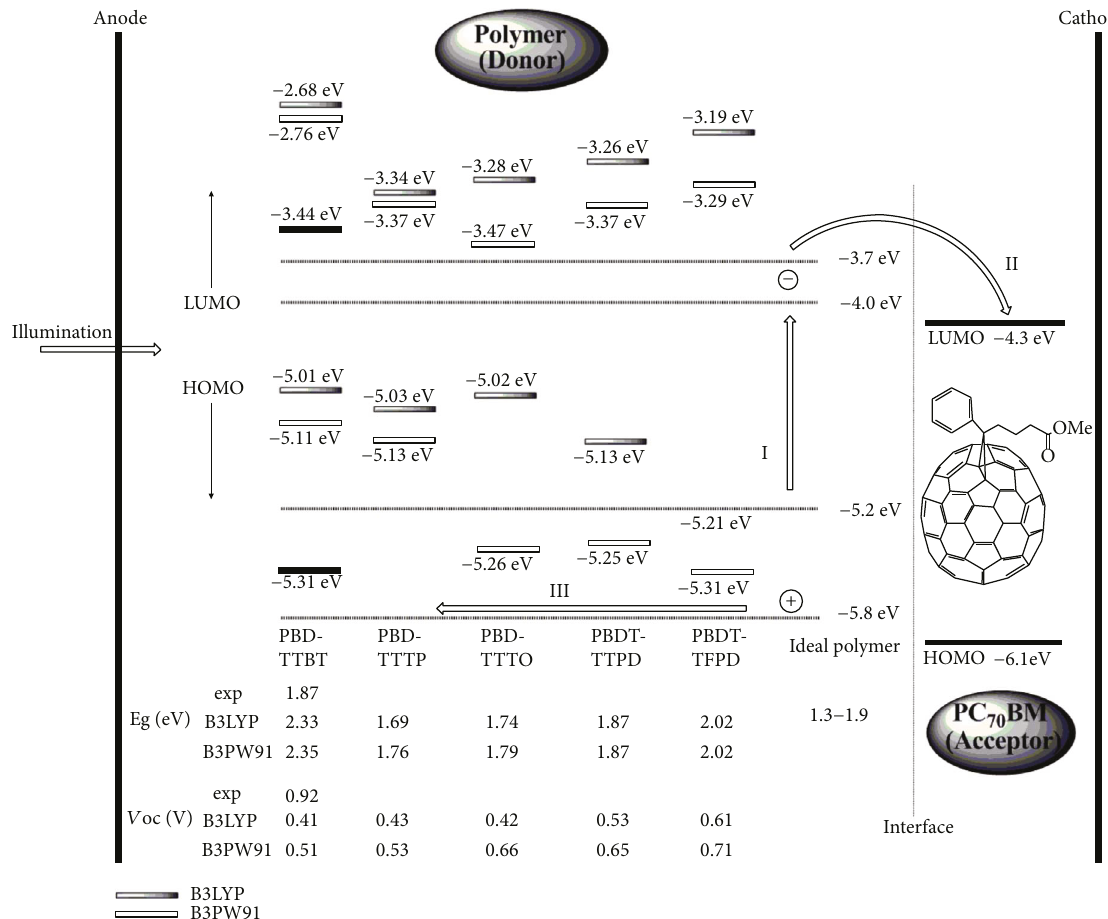
Figure 5: Photoelectric conversion process diagram and energy levels of polymers. (exp represents the values of the experimental measures). Table 2: Bandwidth (eV) and e ff ective mass ( m ∗ ). Conduction band Valance Polymer